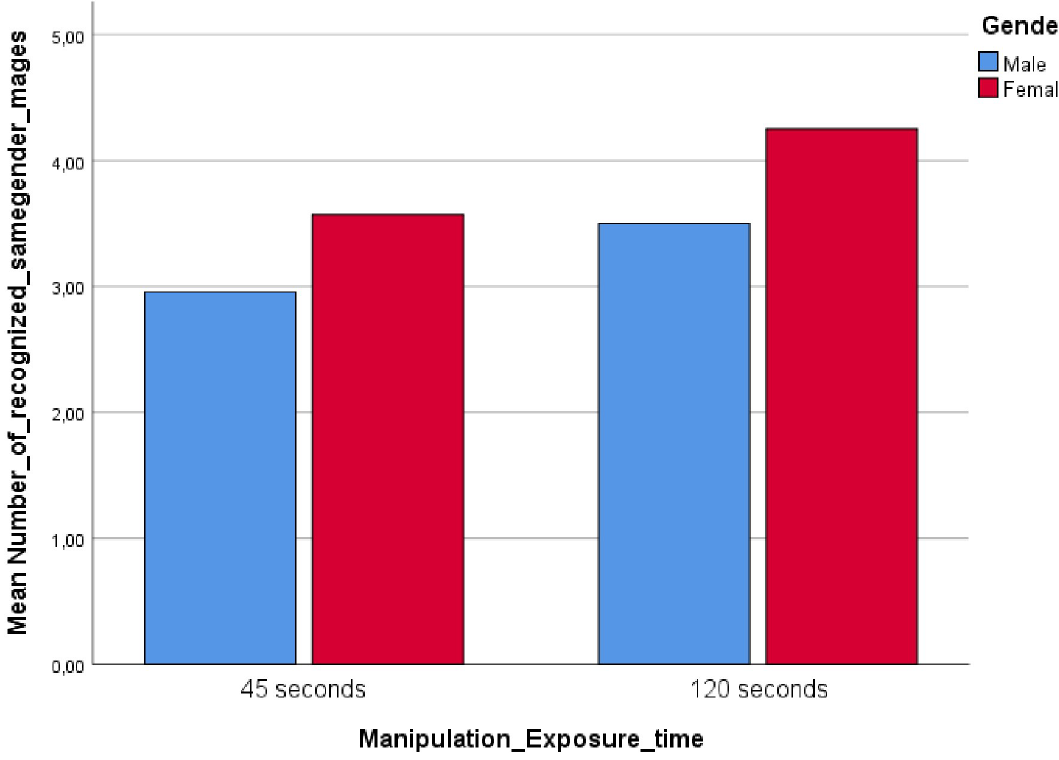
Fig 5. Study 4: Interaction between exposure time and